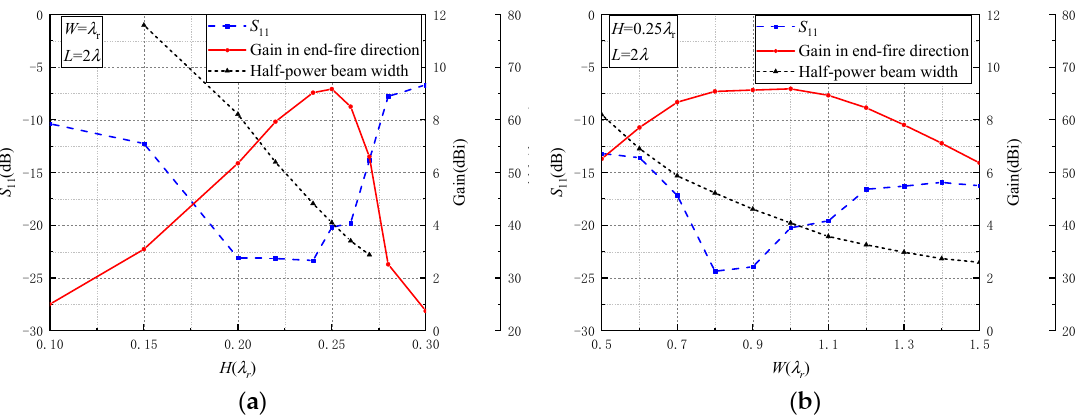
Figure 3. Performance of the proposed antenna: ( a ) with different dielectric slab thickness H , ( b ) with different dielectric slab width W , where λ r = λ /